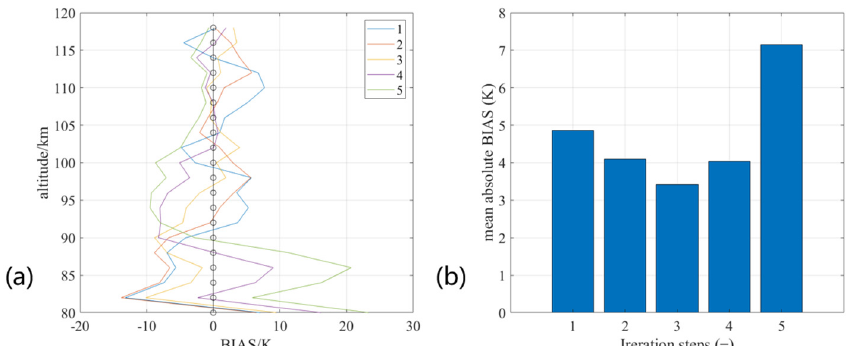
Figure 11. Bias of atmospheric temperature in MLT region: ( a ) the bias between retrieved tempera- ture and actual temperature under different iteration steps, ( b ) the mean absolute bias between re- trieved temperature and actual temperature under different iteration steps.